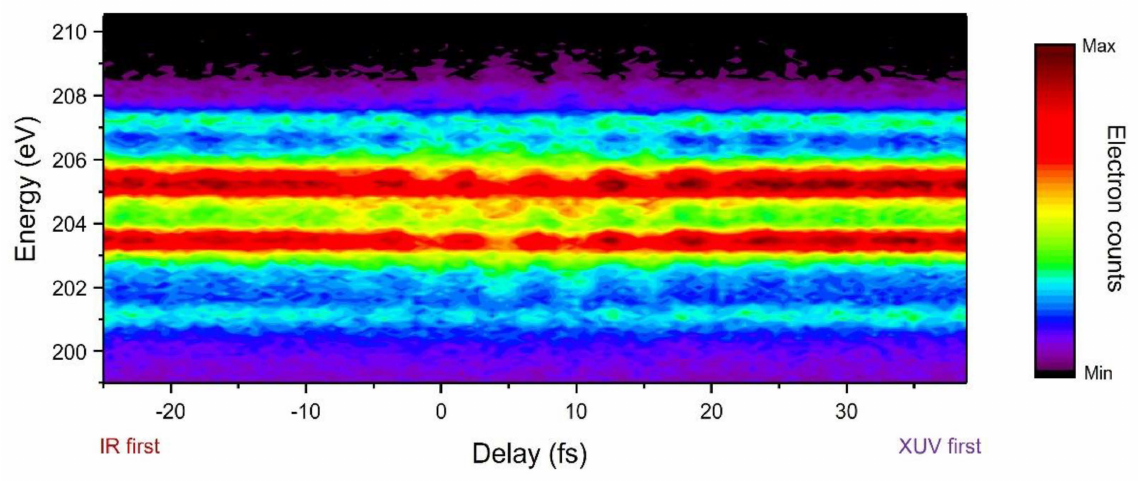
Figure 7. Attosecond streaking